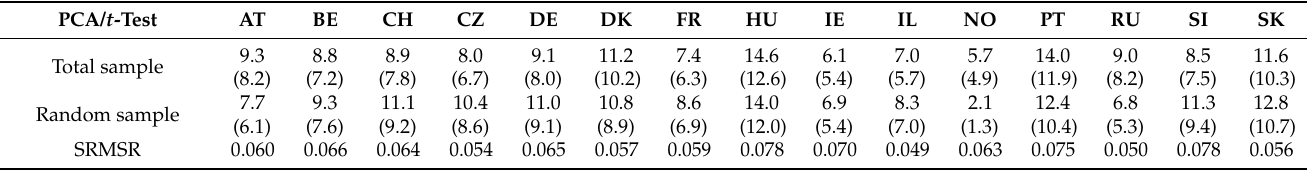
Table 7. Results of PCA/ t -test procedure (proportion of significant t -tests and lower bound of CI) and the SRMSR statistics for the individual countries.